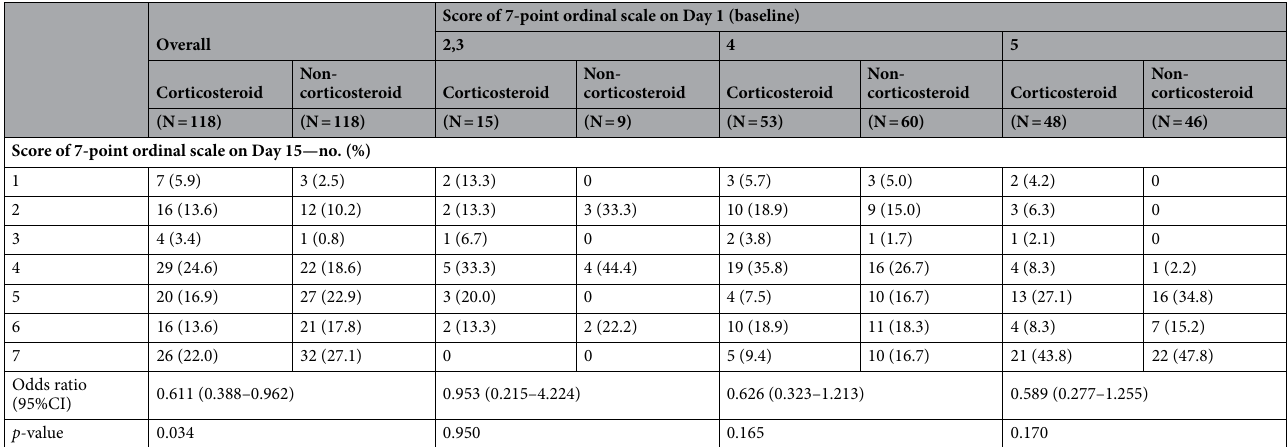
Table 3. Primary outcome. Because only a few patients had a baseline 7-point ordinal score of 3, the patients with a baseline score of 2 and 3 were combined for the analysis. Categorical variables were presented as numbers (%). Ordinal variables were compared between groups using a proportional odds model. A p value of < 0.05 was considered statistically significant. CI, confidence